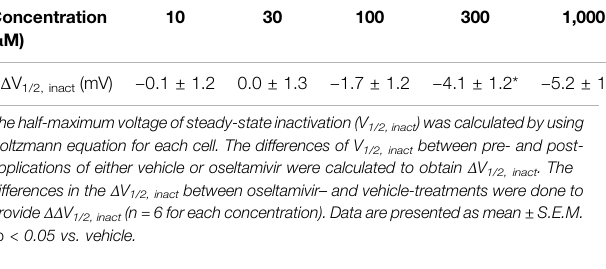
TABLE 2 | Electrophysiological effects on the inter-atrial conduction and effective refractory period. Drug Oseltamivir Pilsicainide Dose (mg/kg/10 min, i.v.)